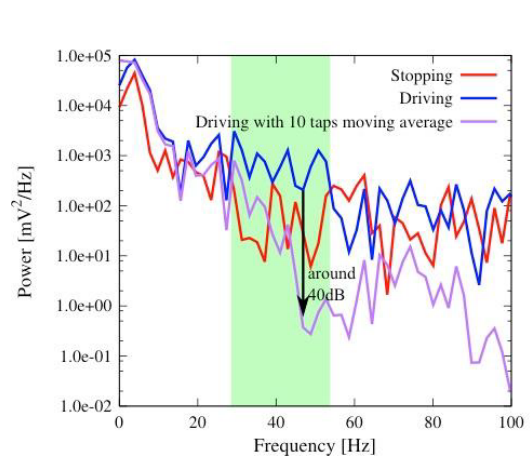
Figure 5: Frequency spectra of acquired ECG signals.